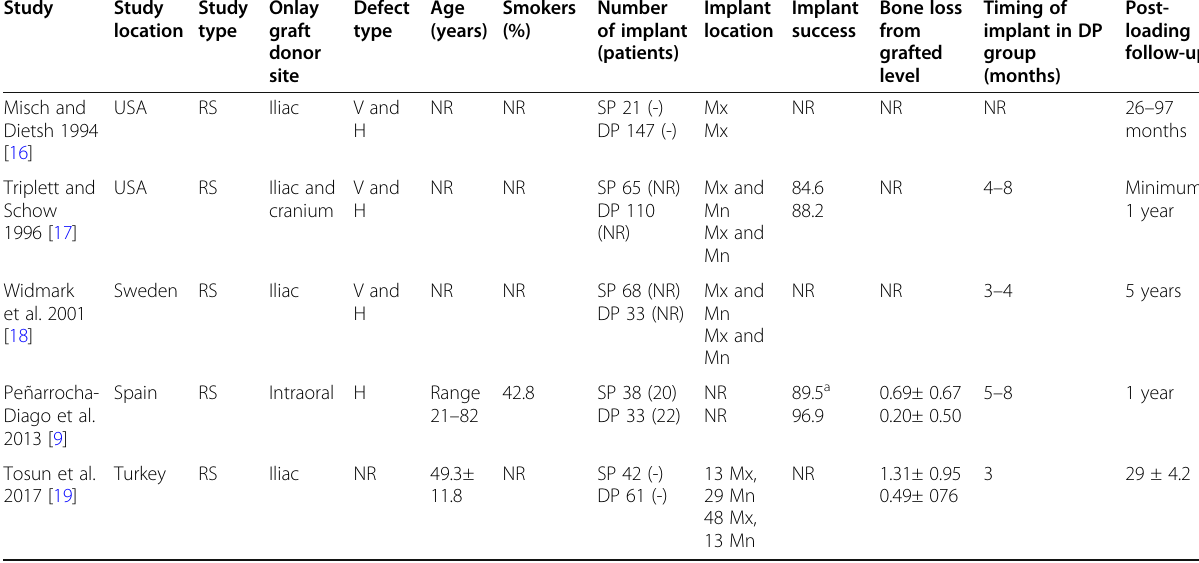
Table 2 Characteristics of comparative studies